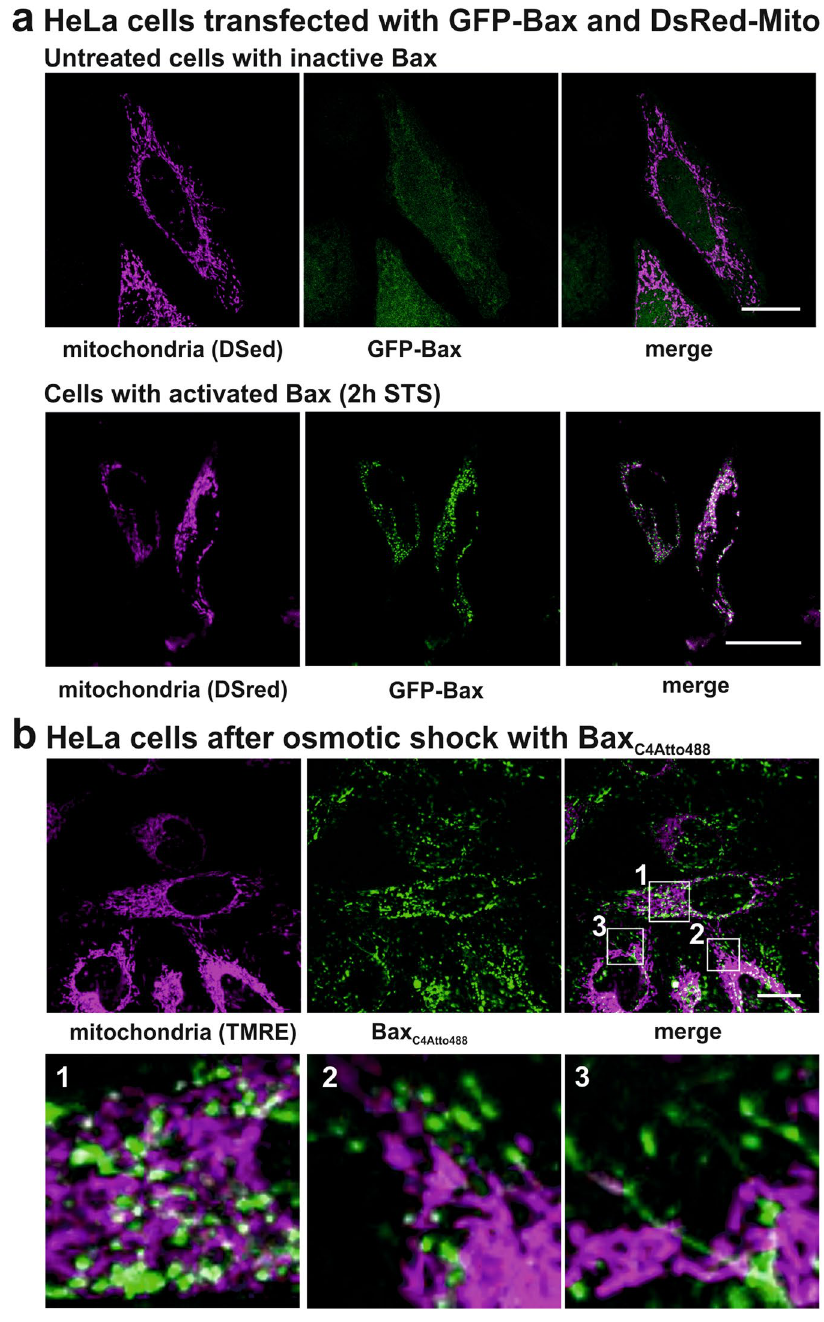
Figure 6. Comparison of the localization of Bax expressed in cells or transferred by osmotic shock. ( a ) HeLa cells transfected with plasmids for the mitochondrial marker DsRed-Mito (magenta) and GFP-Bax (green) before and after pro-apoptotic stimuli (1 µ M Staurosporin, STS). ( b ) HeLa cells after osmotic shock, showing the uptake of Bax C4Atto488 (green). To visualize the mitochondria and their integrity, TMRE (magenta) was added as mitochondrial marker. Upper row: overview images; lower row: enlarged sections. Scalebar: 20 µ m. Additional control experiments are given in Supp. Fig.